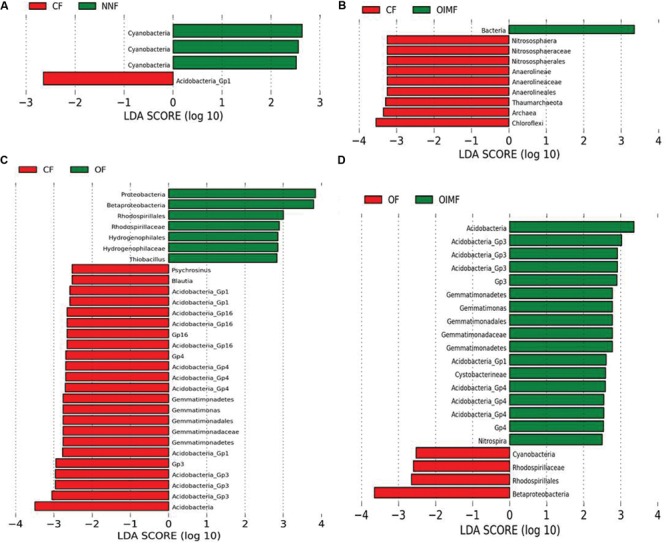
Liner discriminant analysis coupled with effect size measurements identifies the differentially abundant taxa between fertilizer regimes: NNF vs. CF treatments (A), CF vs. OIMF treatments (B), CF vs. OF treatments (C), and OF vs. OIMF treatments (D). Lineages with LDA values higher than 2.5 are displayed.